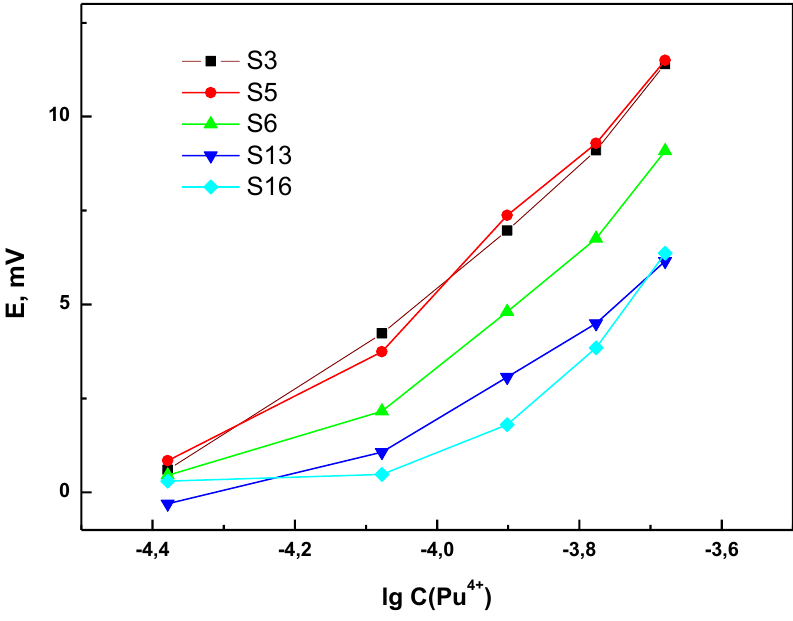
Figure 3. Potentiometric response curves to Pu 4+ obtained in the presence of 500 mg/L U in 1.5 M HNO 3 .